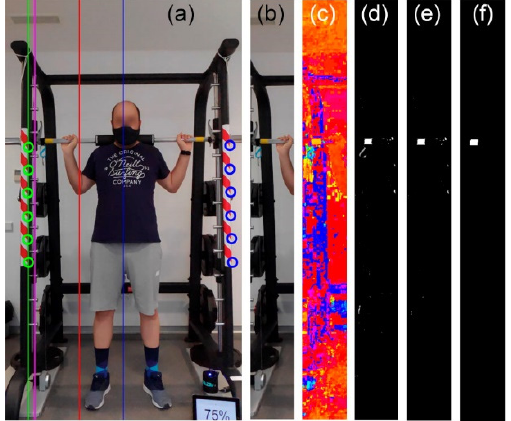
Figure 5. Automatic detection of the left barbell marker. ( a ) Original image with vertical lines showing RANSAC adjustment to the bottom right corners (green); parallel line located to the right (magenta); line dividing the image in half (blue), and a line halfway between magenta and blue (red). ( b ) Subimage selected as the portion between magenta and red. ( c ) Hue component of ( b ). ( d ) 1- circularDif to the selected yellow tone. ( e ) Image ( d ) binarized. ( f ) Image ( e ) tophat bandpass filtered.